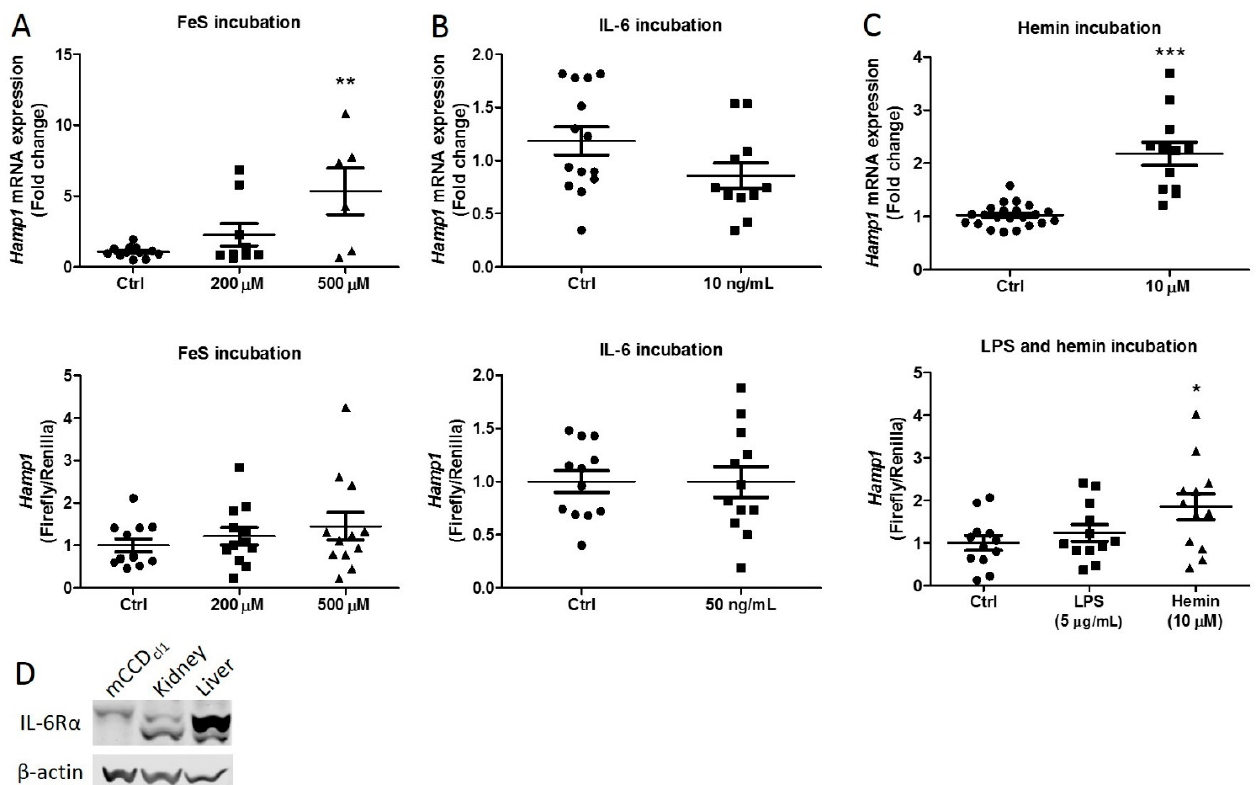
Figure 1. The effect of inflammation and iron on hepcidin expression in mCCD cl1 cells. Hepcidin mRNA expression and luciferase activity after ( A ) 4 h of IL-6 incubation, ( B ) 16 h of FeS incubation, and ( C ) 4 h of hemin and LPS incubation. PBS was used as a control. ( D ) Western blot image of the IL-6 receptor (IL-6R α ) in mCCD cl1 lysate, mouse kidney, and mouse liver homogenate. Graphs A to C show the mean ± SEM of at least three independent experiments in duplicate. Circles, squares and triangles show individual data points in the indicated treatment group. * p < 0.05, ** p < 0.01, *** p < 0.001 compared to the control using a one-way ANOVA with Bonferroni’s multiple comparisons test or a t -test.